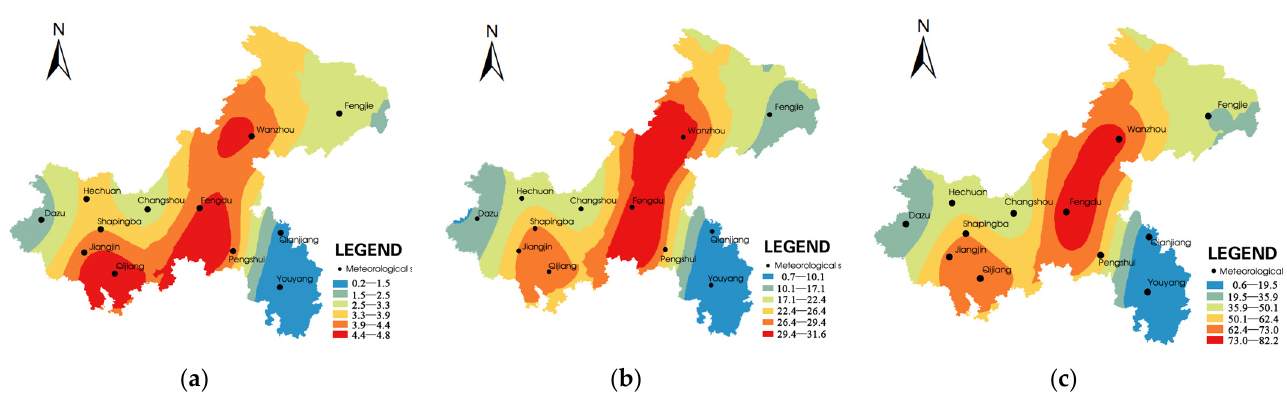
Figure 6. Spatial distribution of the average FHW, NHD, and IHW at each meteorological station in Chongqing; ( a ) spatial distribution of FHW; ( b ) spatial distribution of NHD; ( c ) spatial distribution of IHW.